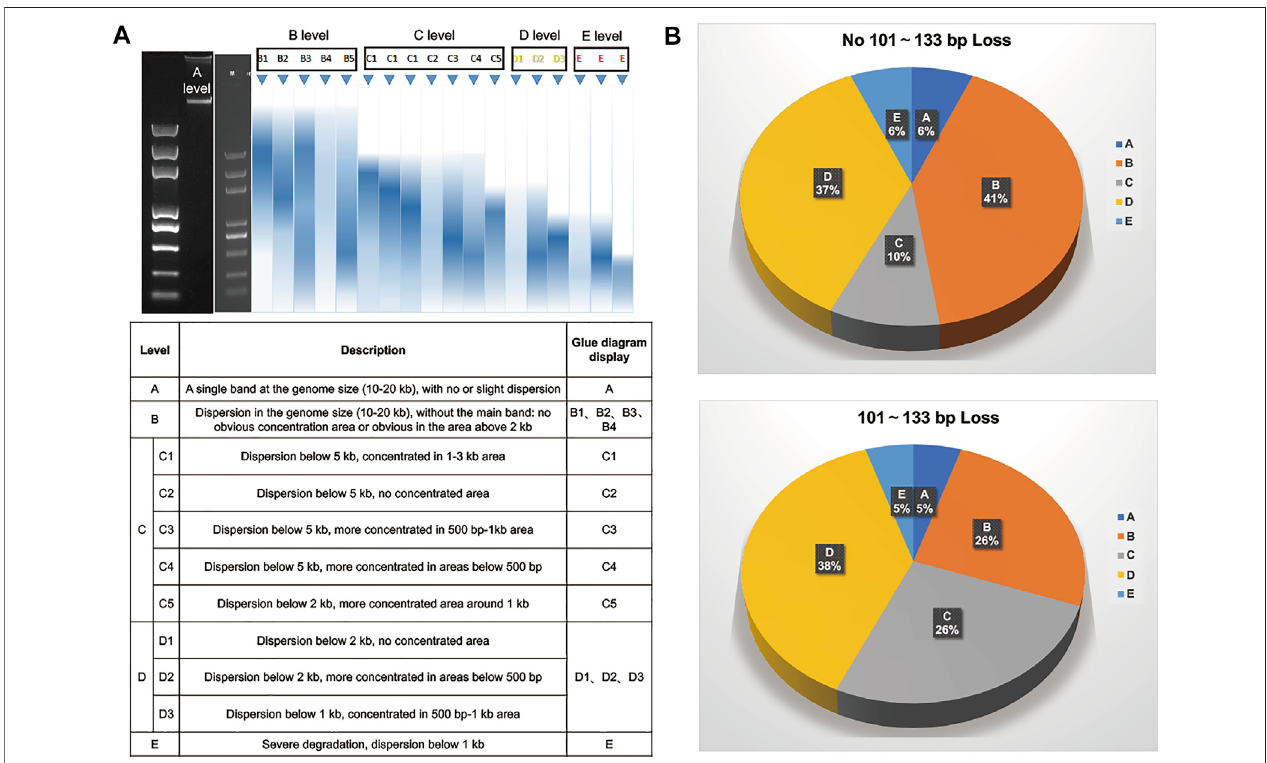
FIGURE 4 | Statistical Analysis On The Quality of 204 Samples. (A) Sample quality grading table of gDNA agarose gel electrophoresis. (B) The distribution of different sample quality levels in samples with and without loss of 101 – 133 bp fragment size. The top fi gure represented sample quality grade distribution of samples without 101 – 133 bp fragment size loss. The bottom fi gure represented sample quality grade distribution of samples with 101 – 133 bp fragment size loss.